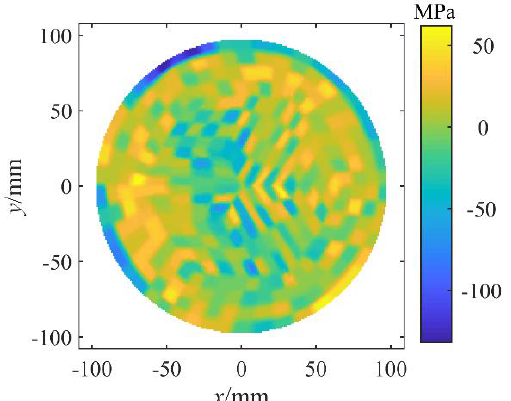
Figure 4. Residual stress distribution calculated from Equation (5).